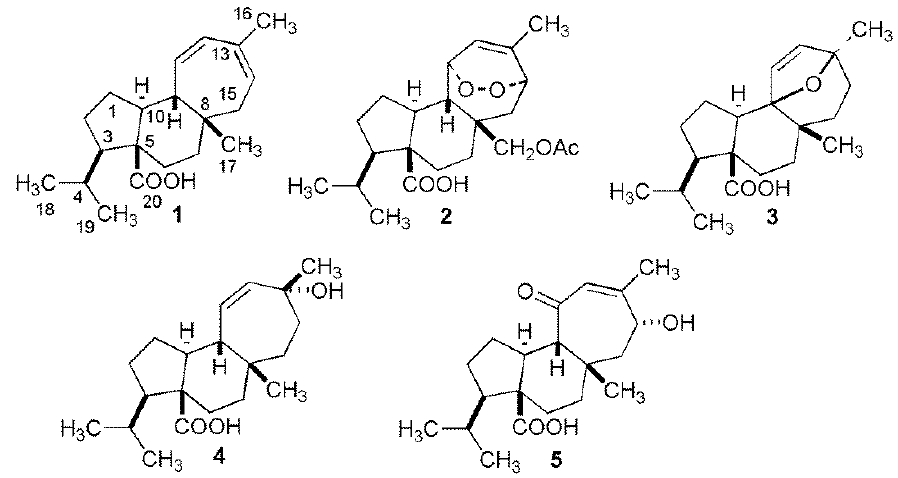
Figure 1. Mulinane diterpenoids isolated from Mulinum crassifolium .